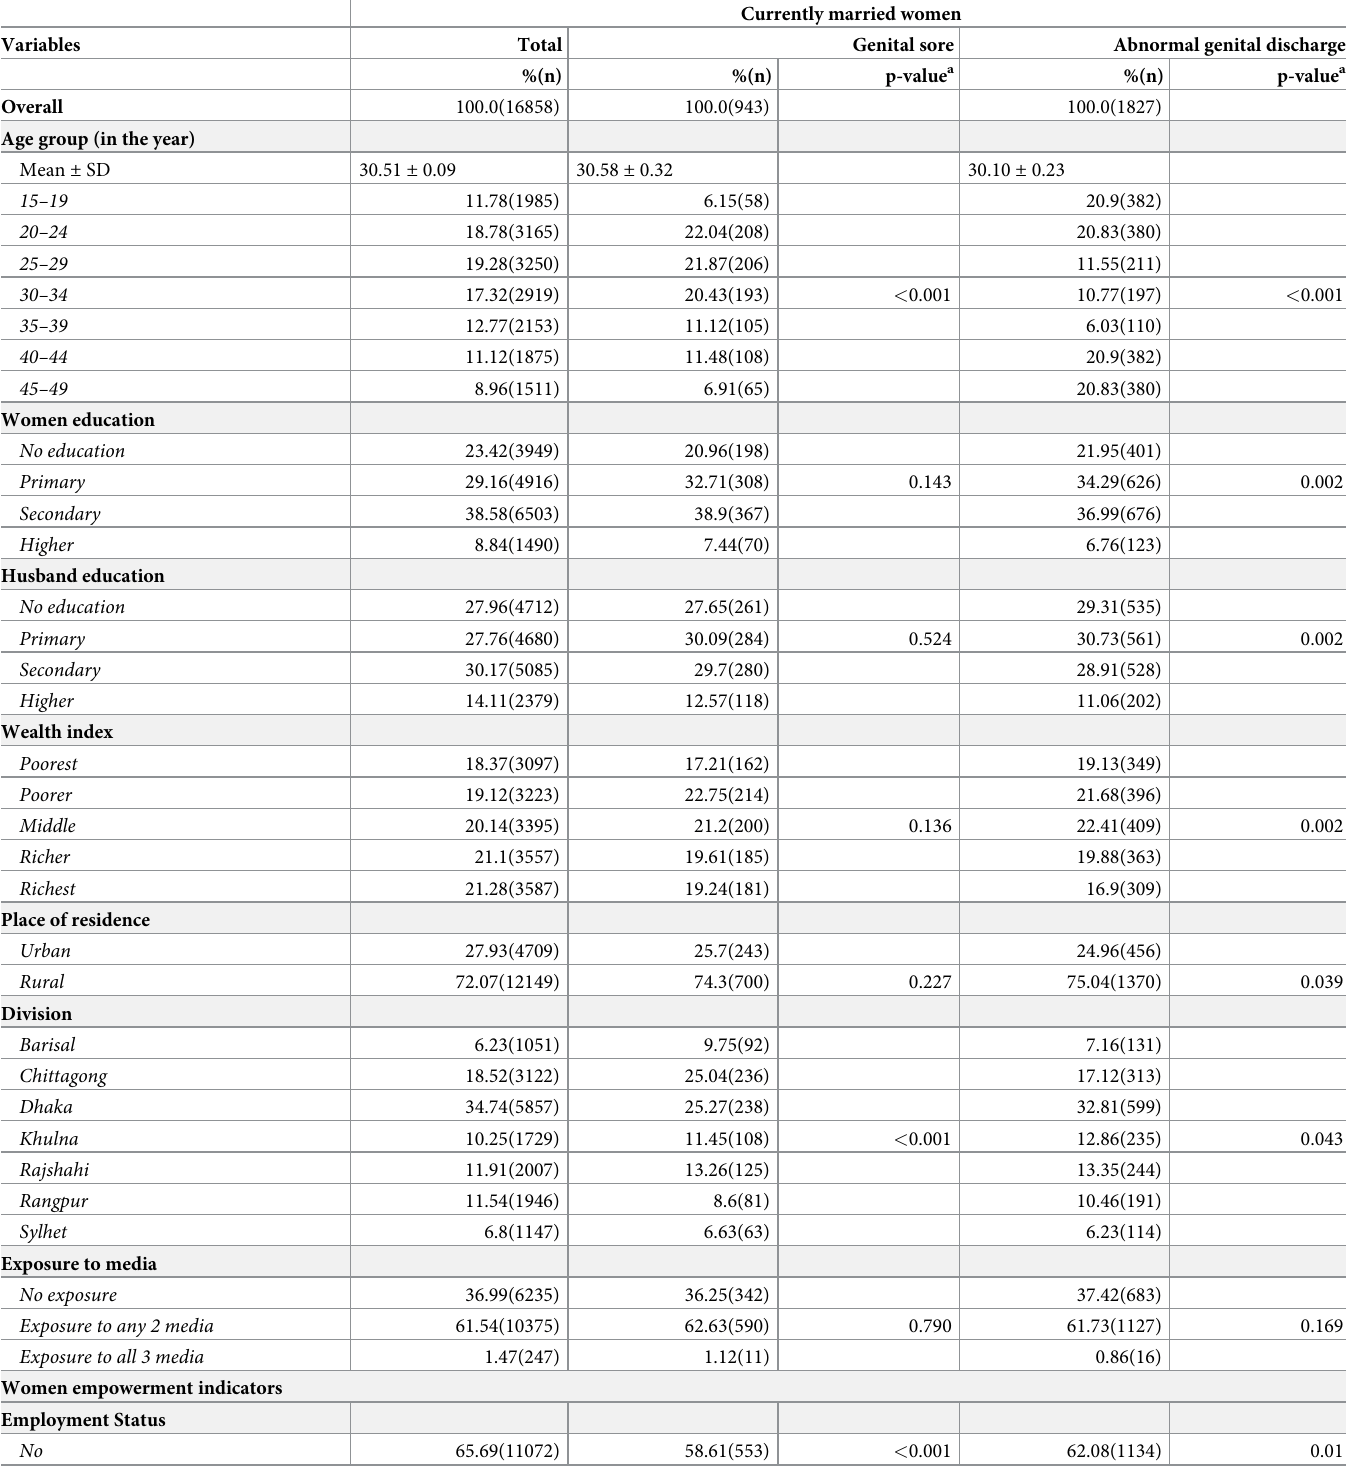
Table 3. Distribution of women’s self-reported experience of genital sore and abnormal genital discharge according to their socio-demographic characteristics and women empowerment